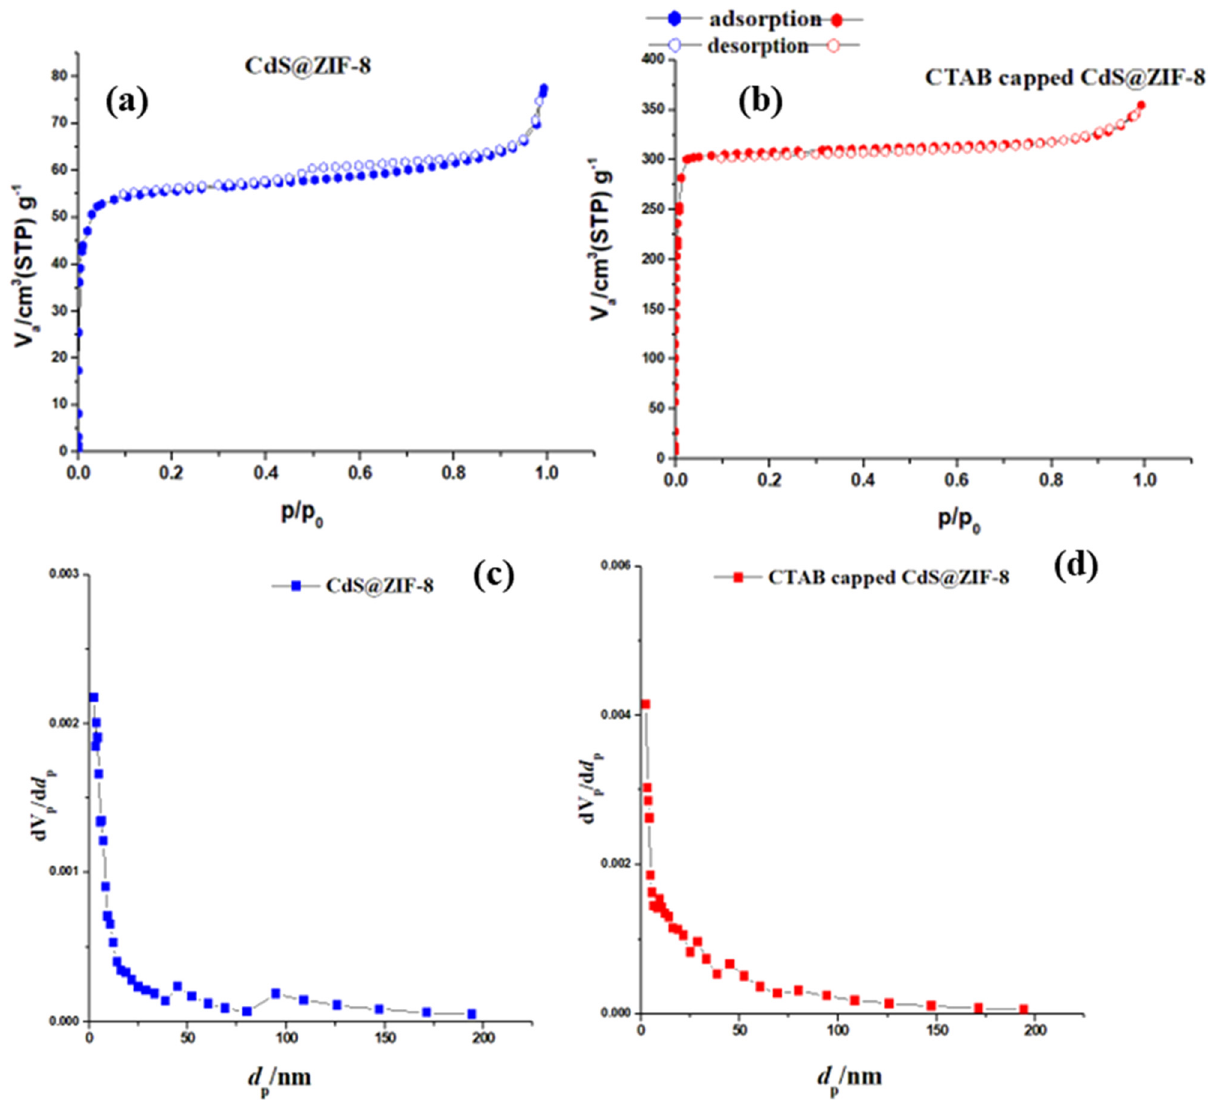
Figure 4: Nitrogen adsorption/desorption isotherms of ( a ) CdS@ZIF - 8 and ( b ) CTAB - capped CdS@ZIF - 8; BJH plots of ( c ) CdS@ZIF - 8 and ( d ) CTAB - capped CdS@ZIF -